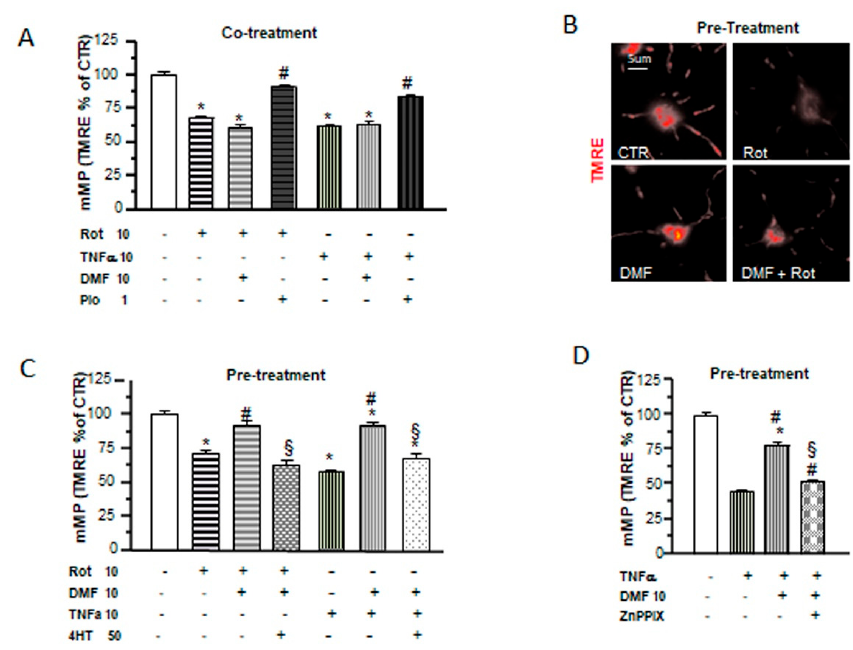
Figure 5. DMF and pio differently protect from inflammatory and mitochondrial insults. OP cultures treated for 24 h with 10-nM rotenone (Rot) or 10-ng/mL TNF- α alone or in the presence of 10-µM DMF or 1-µM pio were loaded with the potentiometric probe TMRE. TMRE fluorescence intensities from mitochondria were measured and shown in the bar graph ( A ). CTR is taken as 100% (mean ± SEM, n = 80-246 mitochondria; * p < 0.05 vs. CTR and # p < 0.05 vs. stress). Examples of OPs loaded with TMRE under different culture conditions are shown ( B) . OP cultures were treated for 24 h with 10-nM rotenone (Rot) or 10-ng/mL TNF- α . Some Rot-treated cultures were pretreated with 10-µM DMF for 24 h alone or in the presence of a 4HT pretreatment. Fluorescence from TMRE-loaded mitochondria was measured after 48 h of treatment and shown in the bar graph ( C ). CTR is taken as 100%. Mean ± SEM; n = 40–260 mitochondria (* p < 0.05 vs. CTR, # p < 0.05 vs. stress, and § p < 0.05 vs. DMF+stress). As in ( C ), OP cultures treated with TNF- α for 24 h were pretreated with DMF alone or in the presence of 2-µM zinc protoorphirin-9 (ZnPPIX). Fluorescence from TMRE-loaded mitochondria was measured and shown in the bar graph ( D ) (mean ± SEM; n = 60–120 mitochondria; * p < 0.05 vs. CTR, # p < 0.05 vs. stress, and § p < 0.05 vs. DMF+stress).